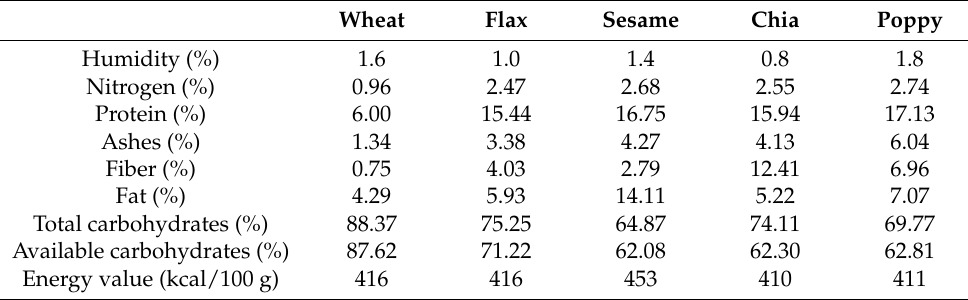
Numbers are means of three independent